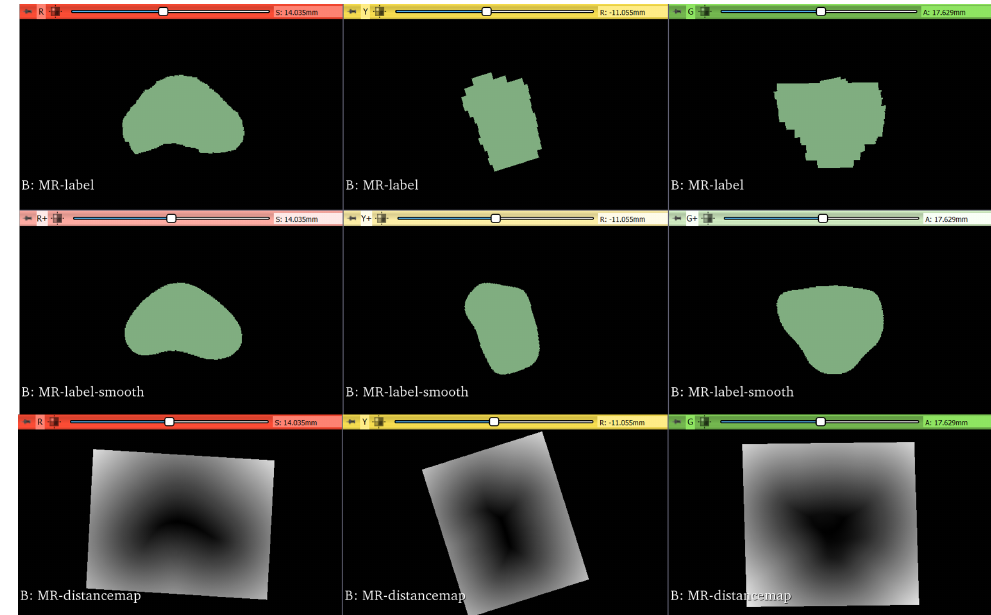
Figure 6. Original ground-truth segmentation masks are reported in the top row. Then, they are smoothed with a Gaussian filter, as depicted in the middle row. Lastly, distance maps are obtained from the smoothed masks, as shown in the bottom